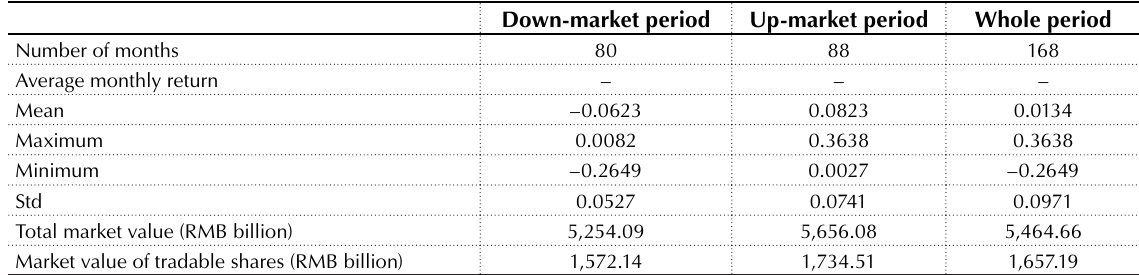
Table 2. Basic characteristics for down-markets, up-markets and full sample over the period